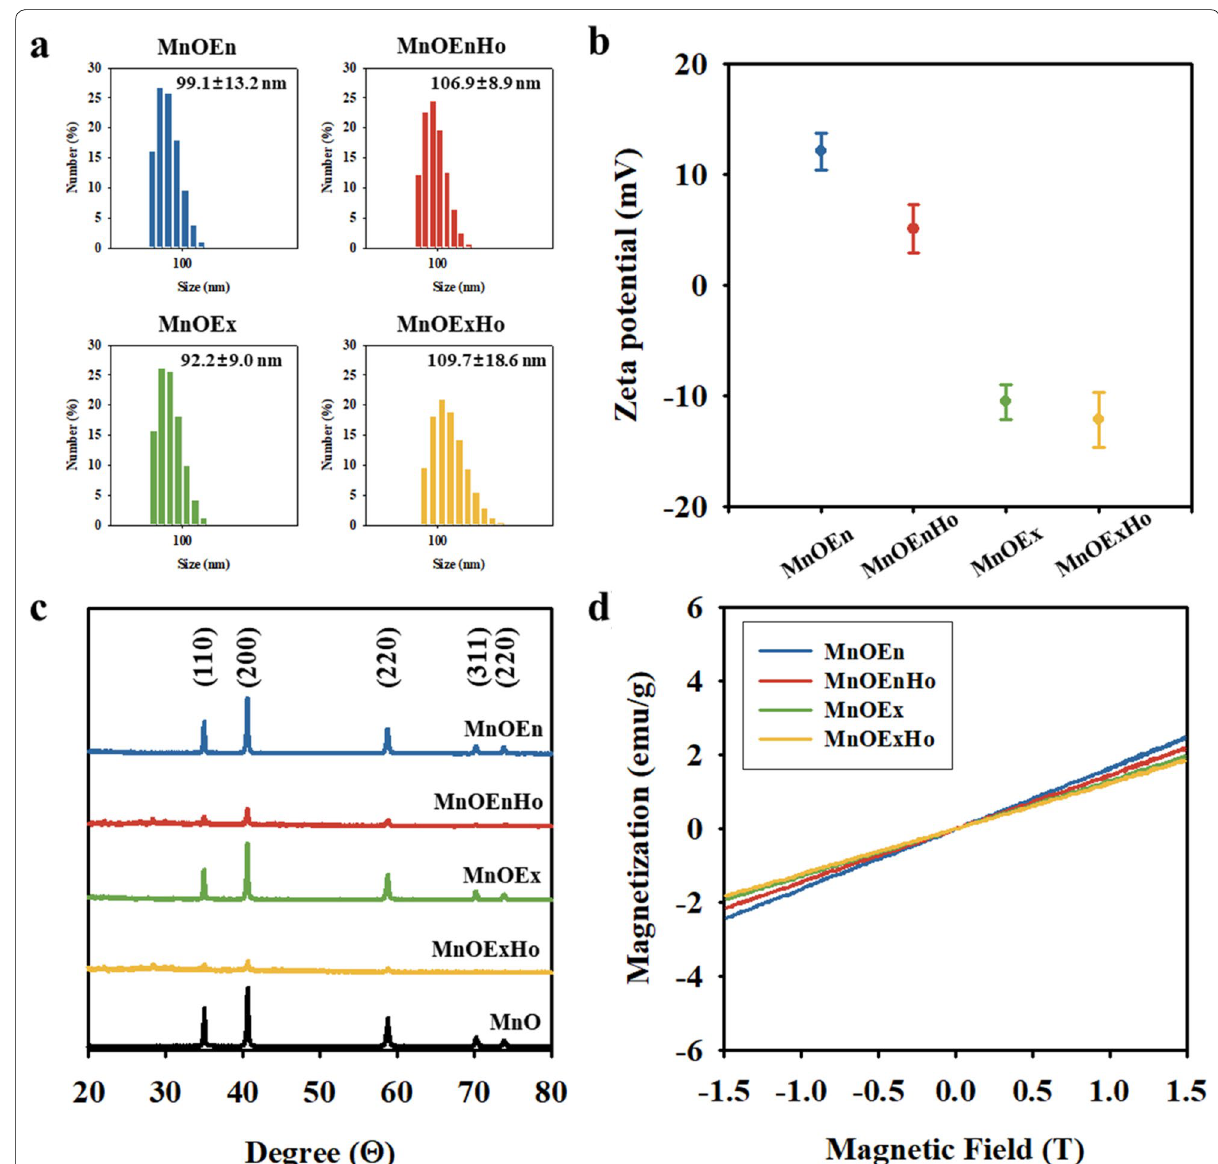
Fig. 3 a Size distributions histogram using dynamic light scattering analysis, b Zeta potential values, c X‑ray diffraction patterns, and d magnetic hysteresis loop analyzed using vibrating sample magnetometer [MnOEn (blue line), MnOEnHo (red line), MnOEx (green line), MnOExHo (yellow line), and MnO (black